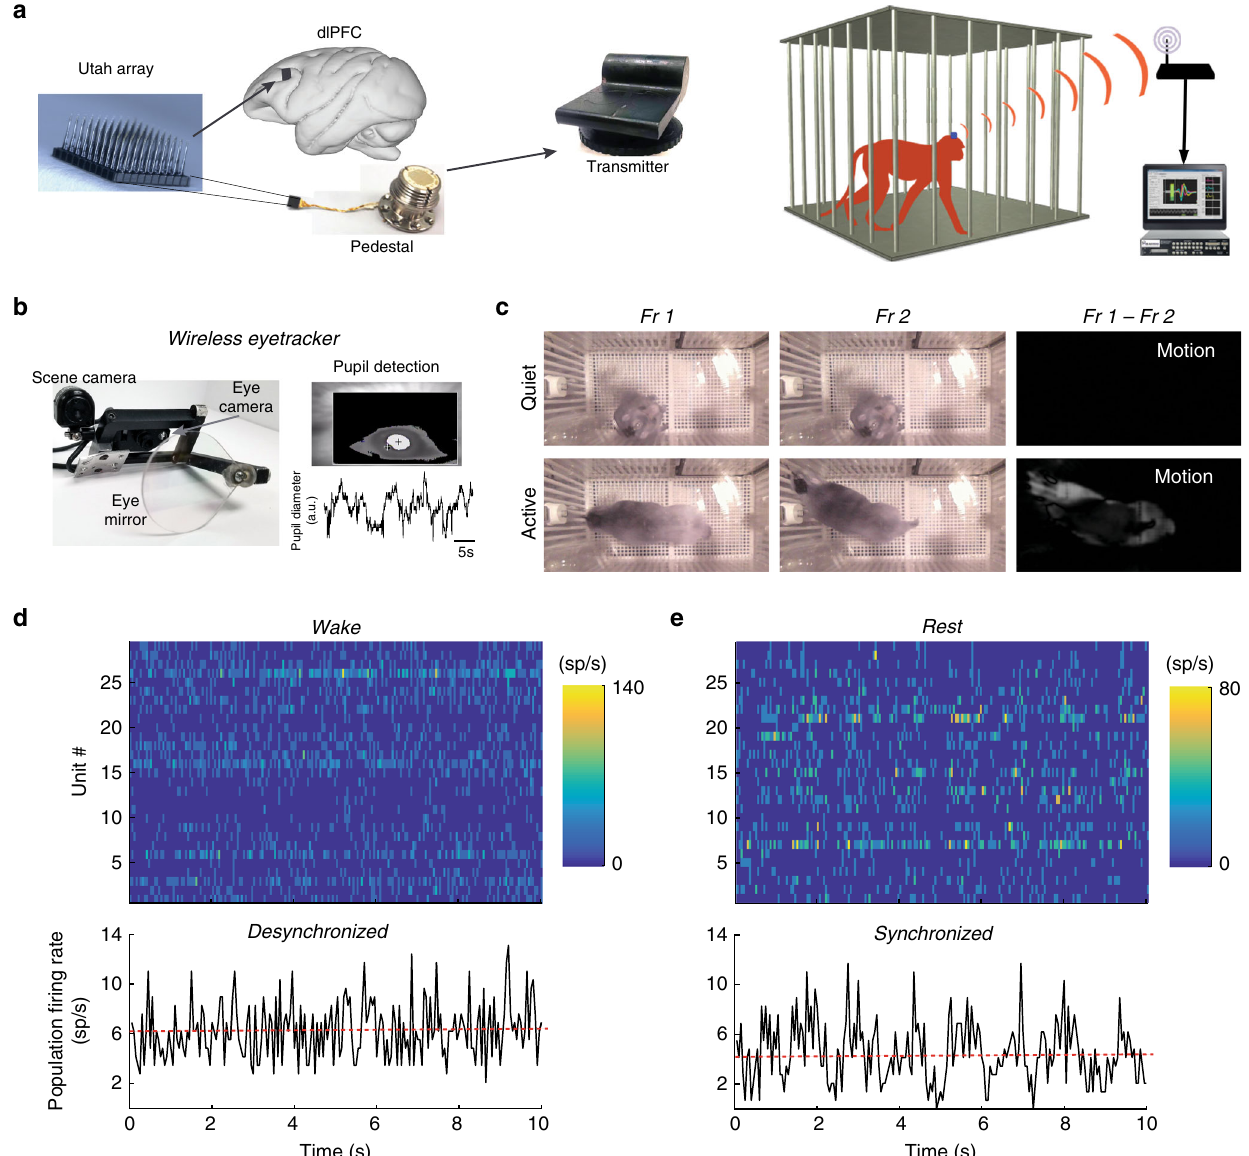
Fig. 1 Integrated system for monitoring behavioral states and cortical activity. a Schematic of wireless recording system from a 96-channel microelectrode array in dlPFC of freely behaving macaque. Array image photo credit: Utah Array — © 2020 Blackrock Microsystems, LLC. Monkey cartoon diagram image credit: Reproduced with permission 35 . © IOP Publishing. All rights reserved. Three-dimensional brain cartoon generated with Scaleable Brain Atlas 36 – 38 . b (Left) Schematic of wireless eye tracking system. (Right, top) Example of wirelessly recorded eye image with pupil detection. (Right, bottom) Example of wirelessly recorded pupil diameter. c Monkey movement is quanti fi ed based on consecutive video frames as the number of pixels that changed in intensity. The average movement during wakefulness for each recording session was used as a threshold to classify 10 s epochs as active or quiet wakefulness. (Top left and top middle) Example of two subsequent frames during quiet wakefulness, (top right) pixel-wise subtraction reveals no motion during this period. (Bottom left and bottom middle) Example of two subsequent frames during active wakefulness. (Bottom right) Pixel-wise subtraction reveals that the monkey is actively behaving during this period. d (top) Example raster showing the fi ring rates of 29 simultaneously recorded single units while the monkey is awake. The spike count in each 10 ms bin was converted to sp/s by scaling by a factor of 100. (Bottom) Population fi ring rate was computed as the average fi ring rate for the population within each 10 ms bin (black trace). The red line shows the average population fi ring rate for the whole 10 s period shown (6.3 sp/s). Population synchrony index (PSI) is 0.0433. PSI quanti fi es the 0.5 – 10 Hz oscillations of the population fi ring rate during the 10 s period. e Same as b , but recorded while the monkey is resting. Low-frequency fl uctuations are apparent in both spike rasters and population fi ring rate. Average population fi ring rate is 4.5 sp/s and PSI is was associated with increased fi ring rates and lower PSI, behavioral states (Fig. 3a, b; Friedman test, p < 0.001; Wilcoxon indicating a desynchronized state (Fig. 2). Quiet wakefulness signed-rank test with Bonferroni correction, p < 0.001 for all represented an intermediate state, with fi ring rates and PSI values pairwise comparisons). These results support the idea that the falling between those of rest and active wakefulness. Population degree of synchrony serves as a readout of cortical state, and may fi ring rates and PSI were signi fi cantly different across all represent the neural substrate of vigilance.